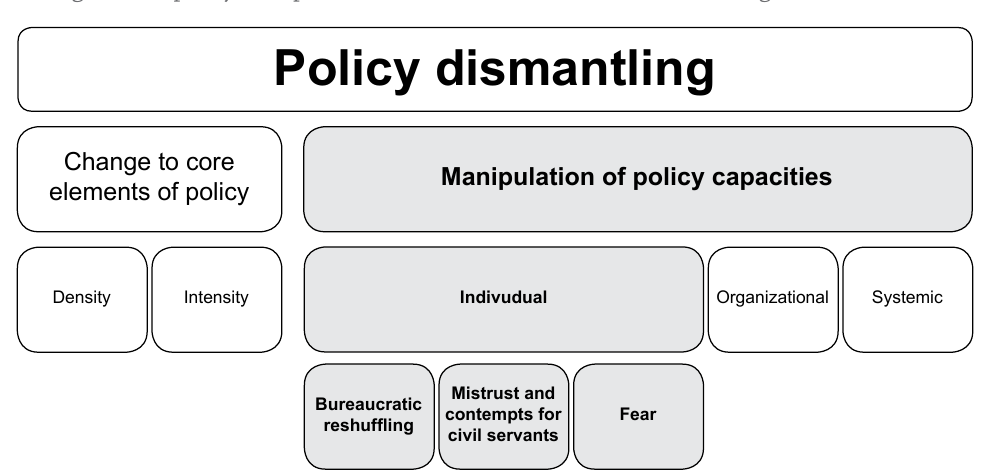
Figure 1. Capacity manipulation in a context of democratic backsliding